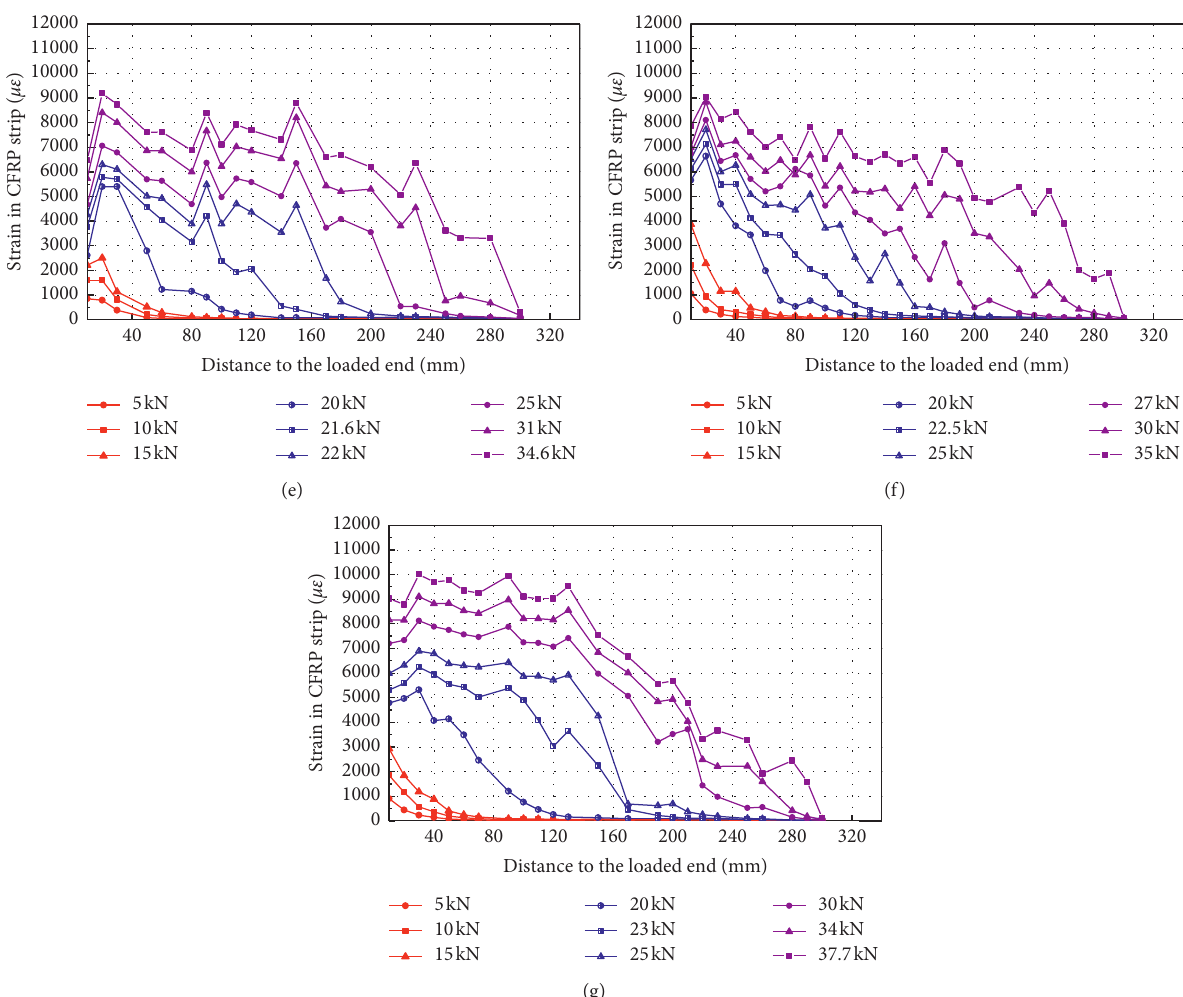
Figure 5: Strain vs distance along sheet: (a) W0L0-3; (b) W50-1; (c) W75-2; (d) W100-2 (L2-2); (e) W150-2; (f) L1-2; (g) L3-1.